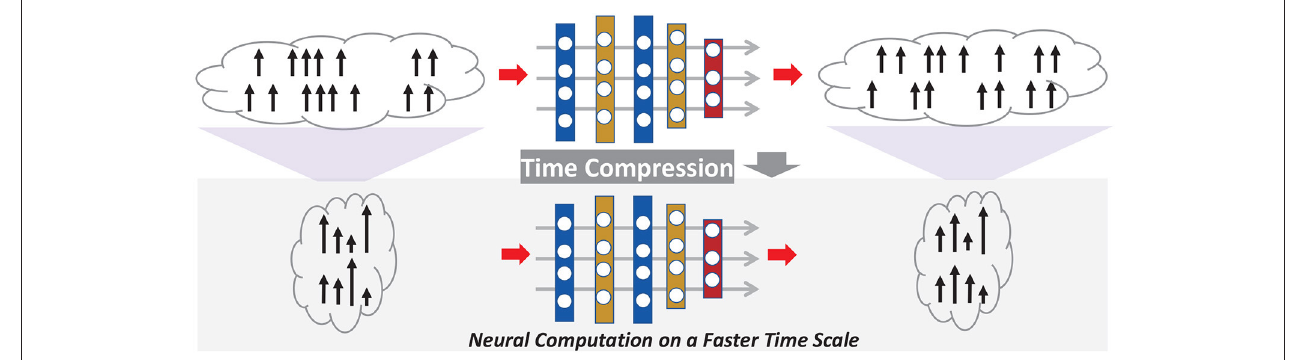
FIGURE 1 | Proposed general time compression for